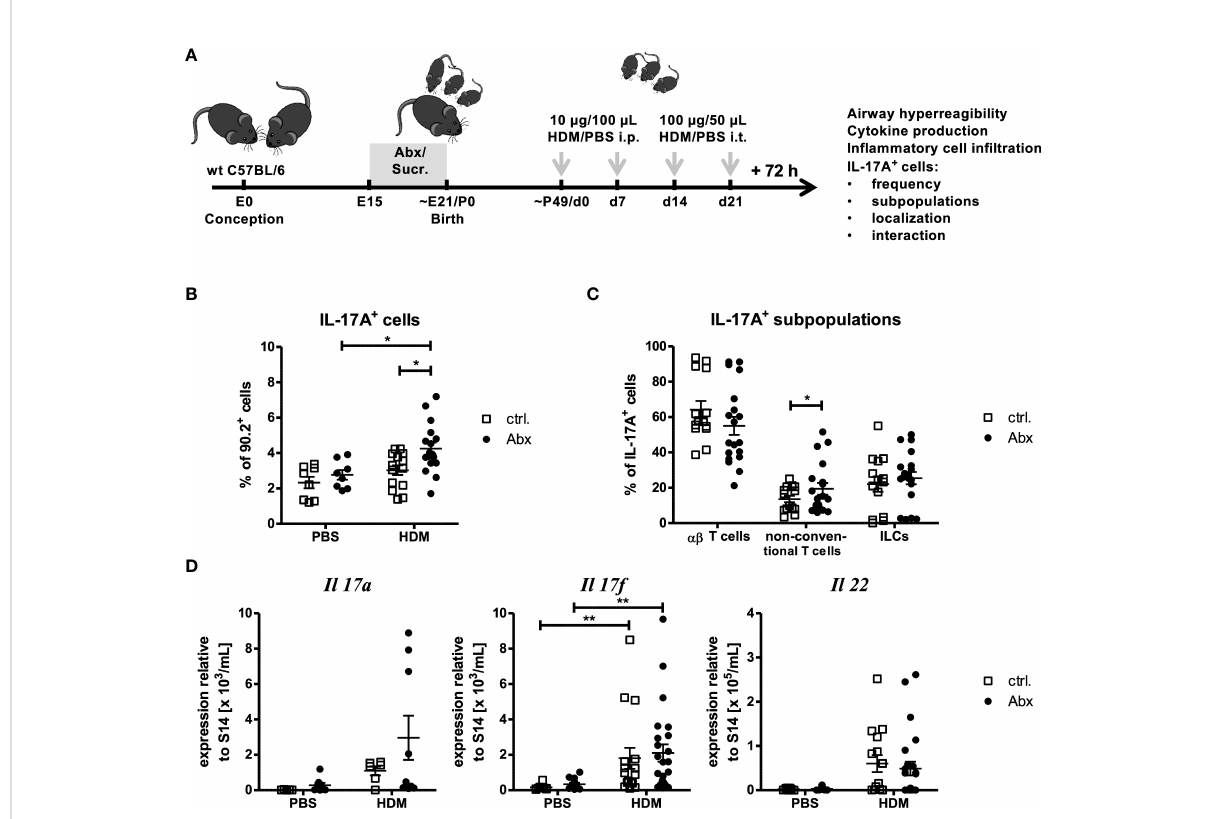
FIGURE 1 Prenatal antibiotic exposure increases the frequency of IL-17A + pulmonary cells without affecting gene expression. (A) C57BL/6 mice were treated with vancomycin, ampicillin and gentamycin (all at 1.0 mg/mL)(Abx) from prenatal day 15 until birth. Mice treated with sucralose served as controls (ctrl.). At 6-8 weeks, offspring C57BL/6 mice were immunized i.p. with 10 µg/100 µL of HDM. Seven days later mice received an additional i.p. injection of HDM. After 14 and 21 days mice were treated with 100 µg/40 µL HDM i.t. Mice treated with PBS served as non- asthmatic controls (B, D). 72 h after the last treatment the asthma phenotype was assessed. (B) Single lung cell suspensions were restimulated with PMA (50 ng/mL) and ionomycin (0.5 mg/mL). After intracellular staining of IL-17A, CD90.2 + lymphocytes were analyzed regarding IL-17A production by fl ow cytometry. (C) To further differentiate IL-17A + populations, CD3 and TCR b expression was analyzed to identify CD3 + TCR b + ab T cells, CD3 + TCR b - non-conventional T cells and CD3 - TCR b - ILCs. (D) Further, 72 h after the last in vivo treatment RNA expression of Th17- related cytokines normalized to the expression of the housekeeping gene S14 by pulmonary cells was assessed. Scatter plot with mean ± SEM; n = 5-25 mice. Each dot represents one mouse. Differences between groups were tested by one-way ANOVA (after passing D ’ Agostino and Pearson omnibus normality Test) and Tukey Post Test)(B), Student T Test (after passing D ’ Agostino and Pearson omnibus normality Test) (C) or Kruskal-Wallis-Test and Dunns ’ s Post Test for signi fi cance (D); * p < 0.05, ** p <